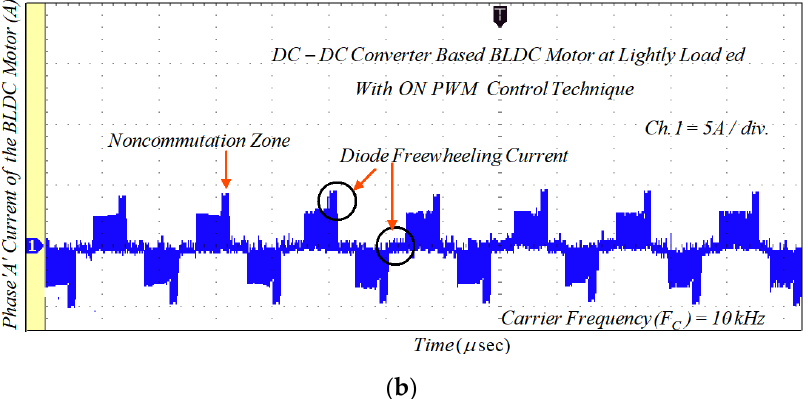
Figure 18. Experimental results of motor current with ON-PWM technique: ( a ) lightly loaded condition, 2 A/div.; and ( b ) full load, 5 A/div.